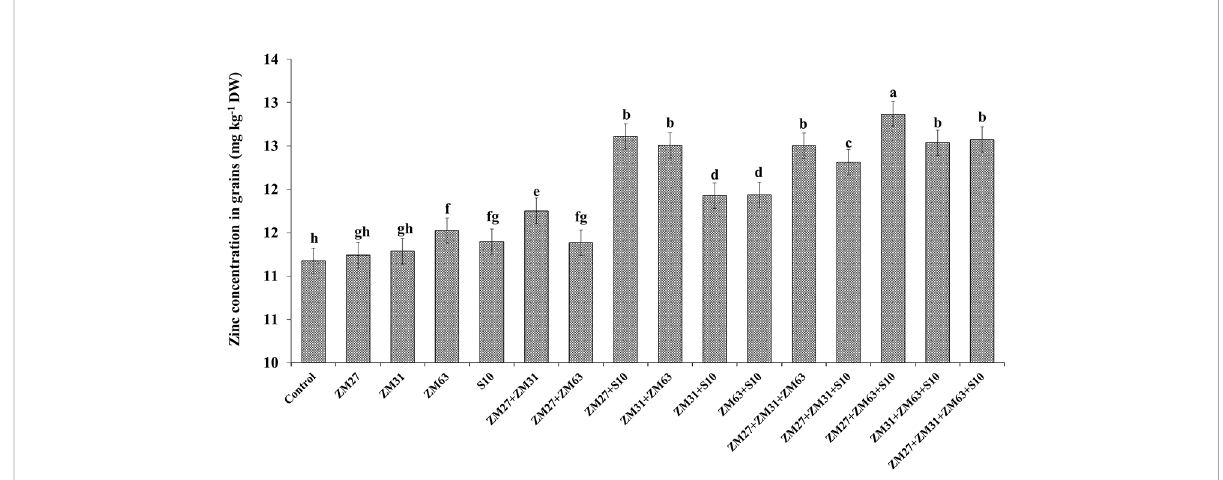
FIGURE 2 Effect of PGPR inoculation on shoot zinc contents in maize in the pot trial. The bars with different letters are signi fi cantly different at p ≤